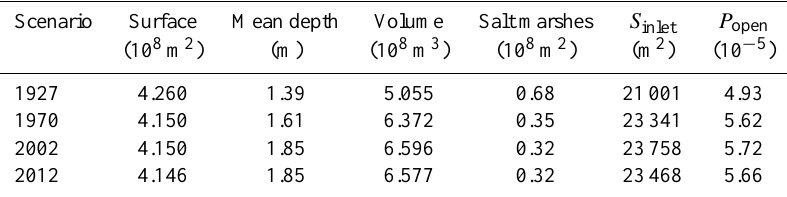
Table 1. Morphometric characteristics of the Venice Lagoon in the 1927, 1970, 2002 and 2012 scenarios in terms of lagoon surface, mean water depth, water volume, extension of salt marshes, total cross-sectional area of inlets ( S inlet ) and openness parameter ( P open ), defined as the ratio between S inlet and the lagoon surface